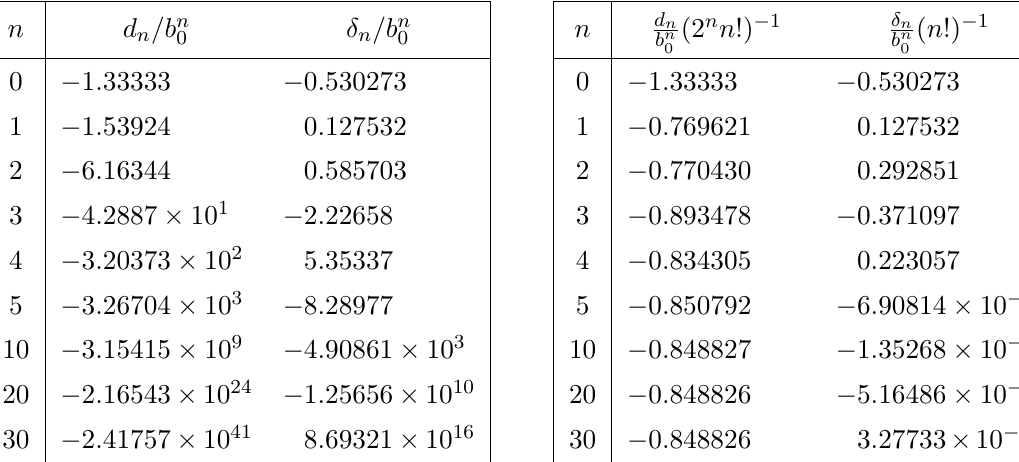
Table 1 . Original perturbative coe(cid:14)cient d n and renormalon subtracted perturbative coe(cid:14)cient (cid:14) n . In the right panel, we divide d n by the large order behavior expected from the u = 1 = 2 renormalon, and divide (cid:14) n by n !. We take n f = 3.